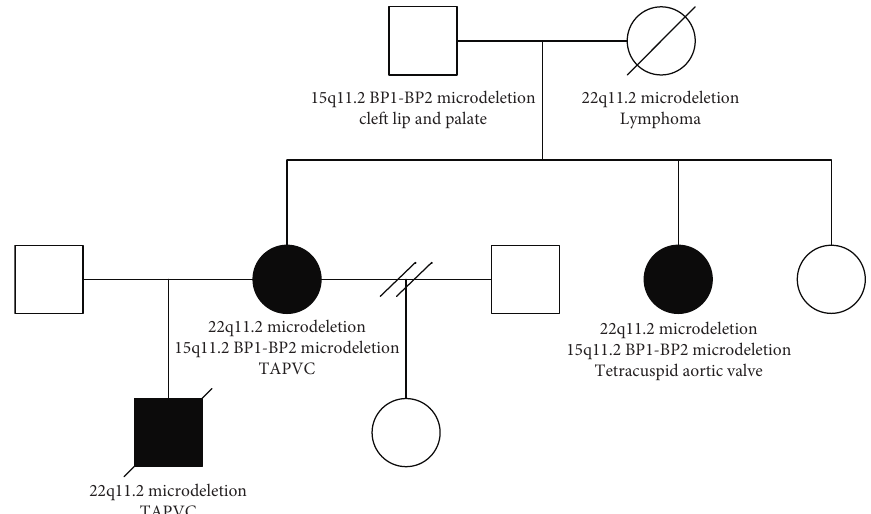
Figure 2: Pedigree of the family under study. Circles indicate females, squares indicate males, and black-filled symbols indicate family members affected by congenital heart